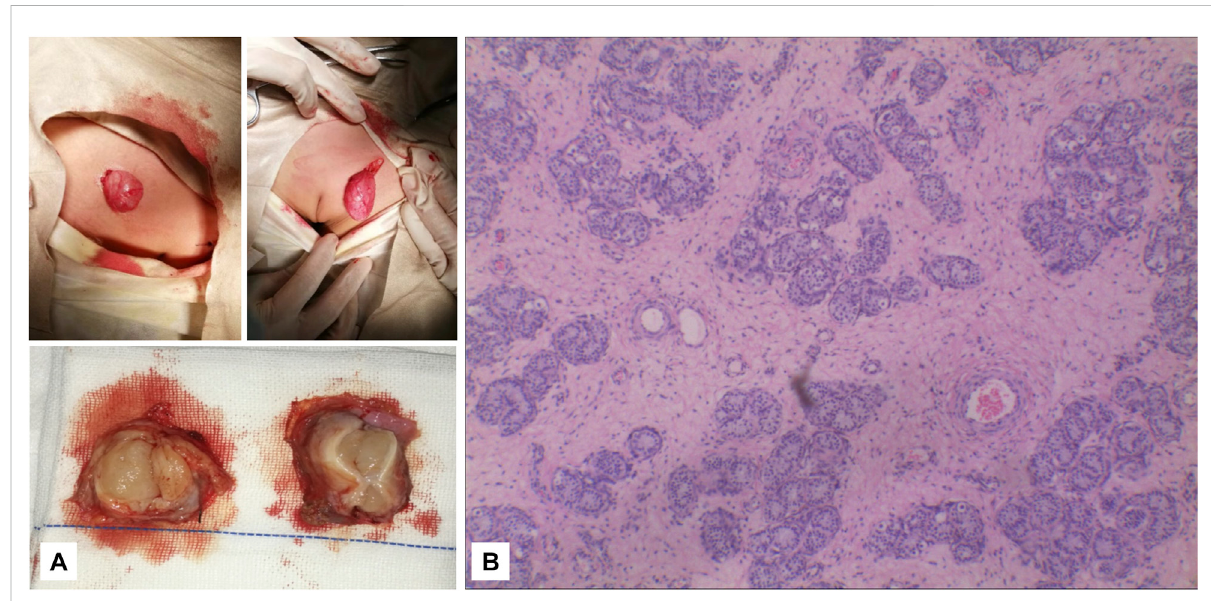
FIGURE 5 (A) Itcanbeseenthatthesubcutaneousellipticalsofttissueofthebilaterallabiamajoraislikeagonad,andthesectionis fi sh-like. (B) Pathology: testicular tissue and vas deferens on the left and testicular tissue on the right (magni fi cation,